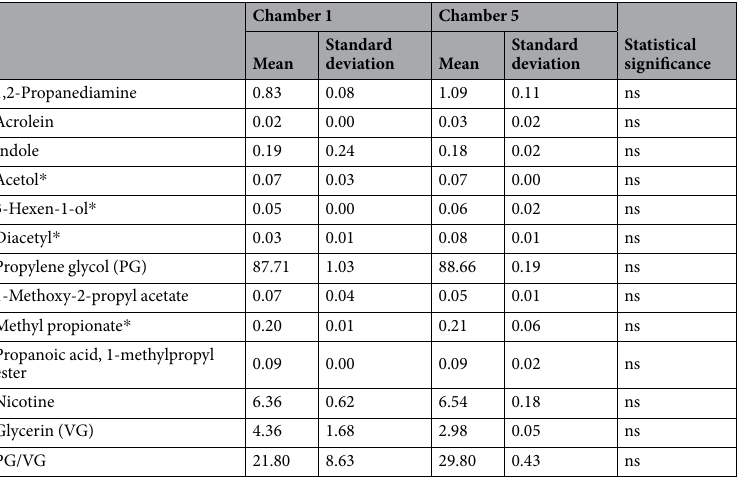
Table 1. Volatile compounds (VOCs) detected in the first and last treatment chambers during exposure to e-cig vapour. Values are expressed as percentage (%) of total peak area of VOCs; factorial analysis of variance (ANOVA) was performed to study the effect of exposure cycling on the formation of VOCs. Statistically different means were investigated (Tukey’s test, P < 0.05); * flavor